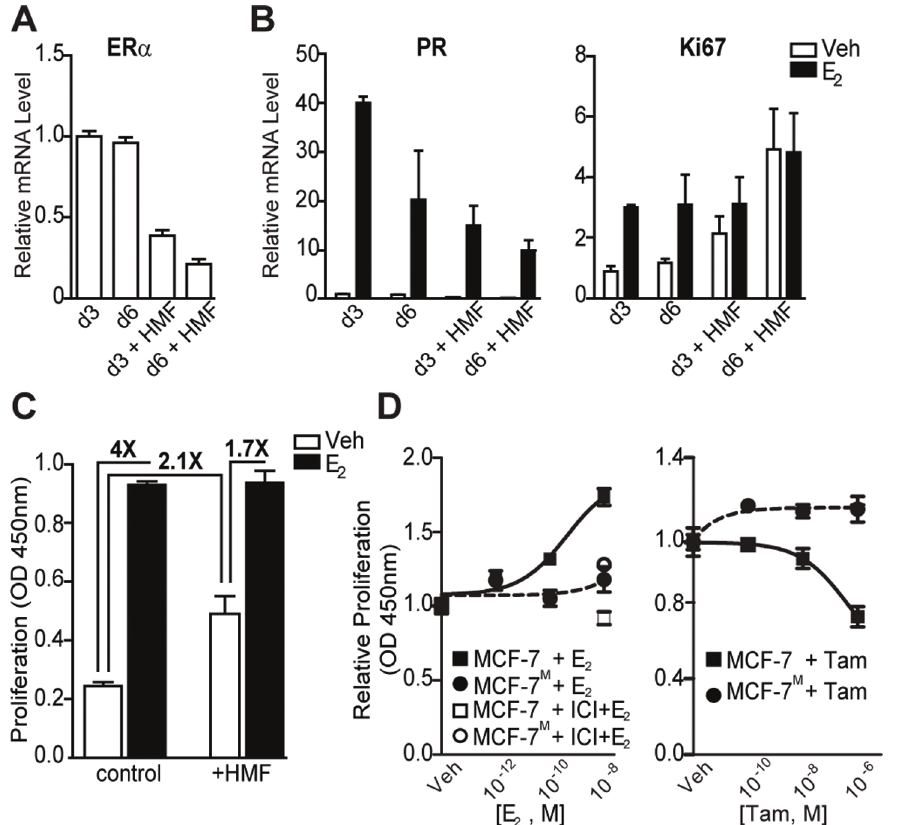
Figure 3. Co-culture with human mammary fibroblasts down-regulates ER a and fosters hormone-independent growth of breast cancer cells. (A) Fibroblasts down-regulate ER a mRNA levels at 3 and 6 days and this effect increases with longer co-culture time. (B) HMF reduce the response of MCF-7 cells to estradiol, as measured by PR, and HMF increases basal Ki67 mRNA at 3 and 6 days and eliminates further increase by E 2 . (C) Co-culture with HMF increases the basal proliferation rate of MCF-7, and decreases the fold change of E 2 stimulation of proliferation monitored at 3 days. (D) MCF-7 M proliferation fails to respond to increasing concentrations of E 2 (left panel) and MCF-7 M growth is not inhibited by treatment with tamoxifen (right). Response in MCF-7 cells alone is shown for comparison.